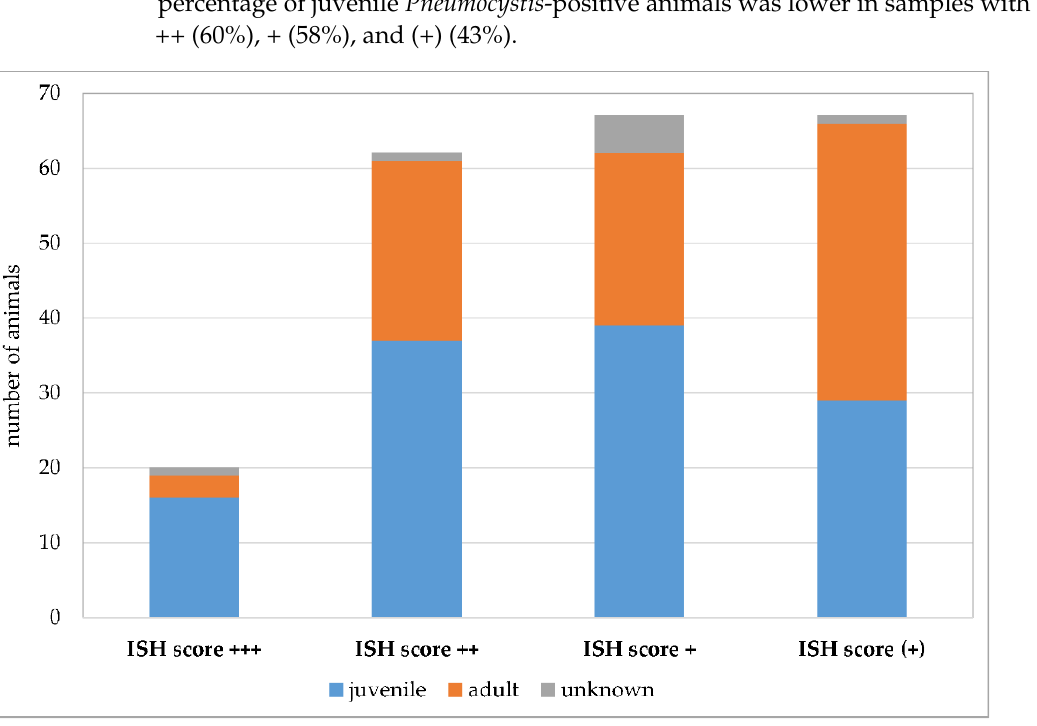
Figure 11. Number of Pneumocystis -positive samples according to the ISH scores +++ (multiple sig- nals), ++ (moderate signals), + (few signals), and (+) (minimal signals). Juvenile animals are shown in blue, adult animals in orange, and animals with unknown age in gray.